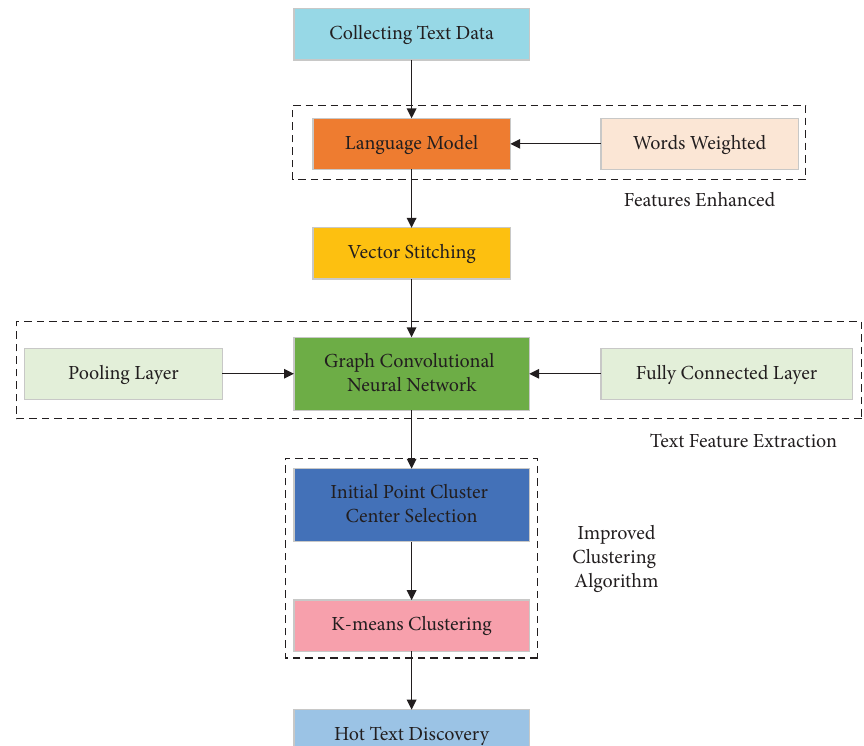
Figure 3: Architecture diagram of media hotspot discovery